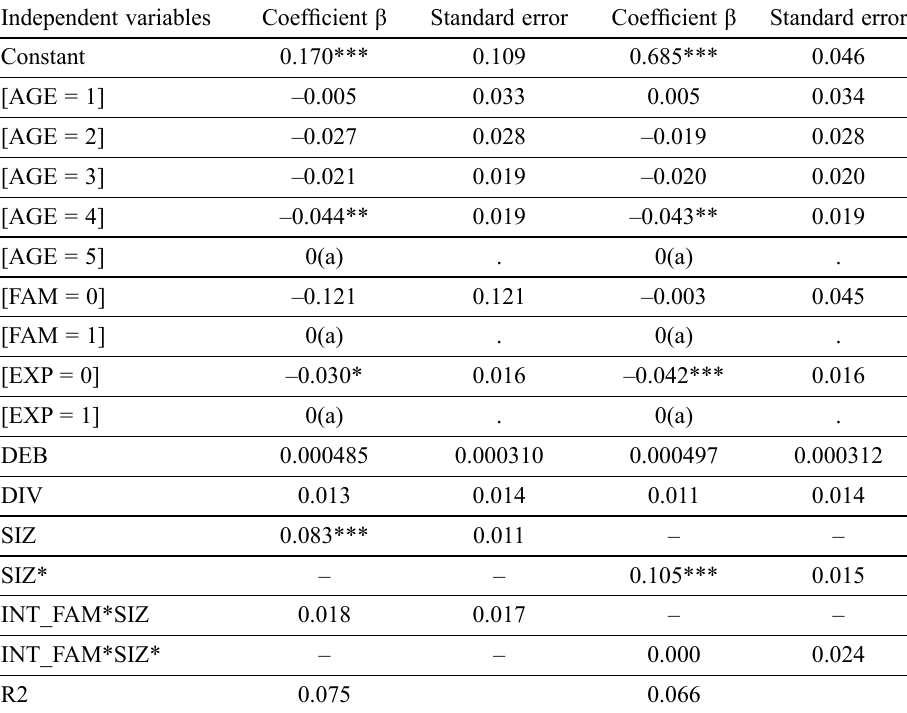
Table 8. Model 3. Dependent variable